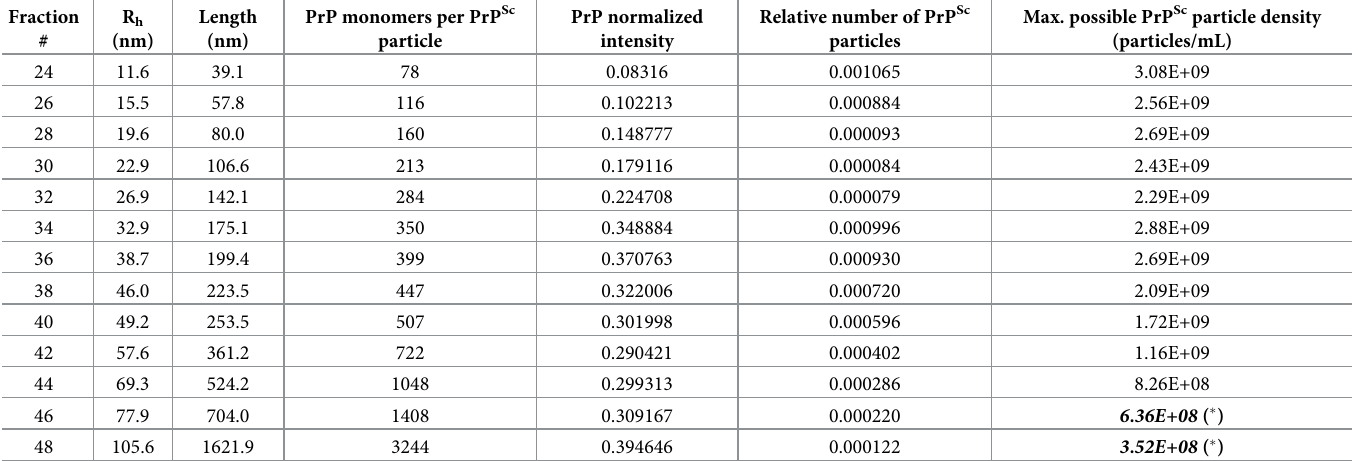
ticle lengths in fractions greater than 15 nm R (Fig 2A and Table 1). h Once particle length was determined, we could use MALS data to directly calculate particle density (see Methods for details). However, because our starting material was brain homoge- nate, particles other than PrP Sc were present in the fractions. To overcome this issue, we ana- > 70nm and highly enriched for PrP Sc ; these lyzed only fractions 46–50, with particles of R h Table 1. Particle density